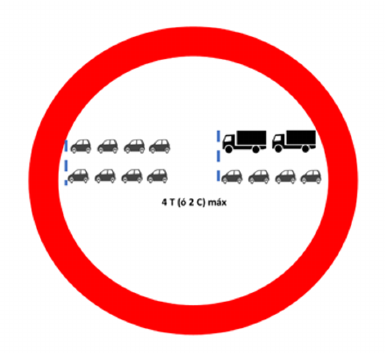
Figure 6. Platoon start signal with maximum platoon sizes.